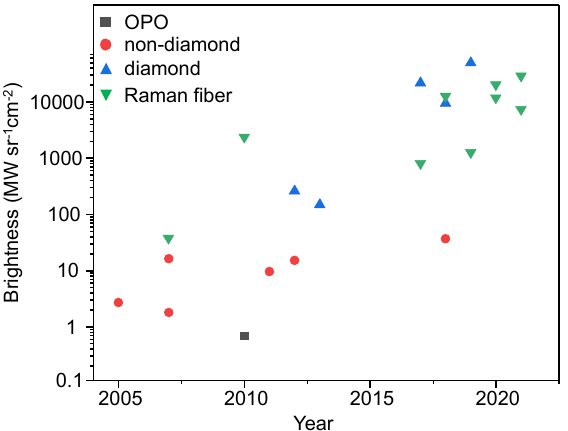
Figure 6. Brightness of CW solid-state nonlinear lasers over the past decade.